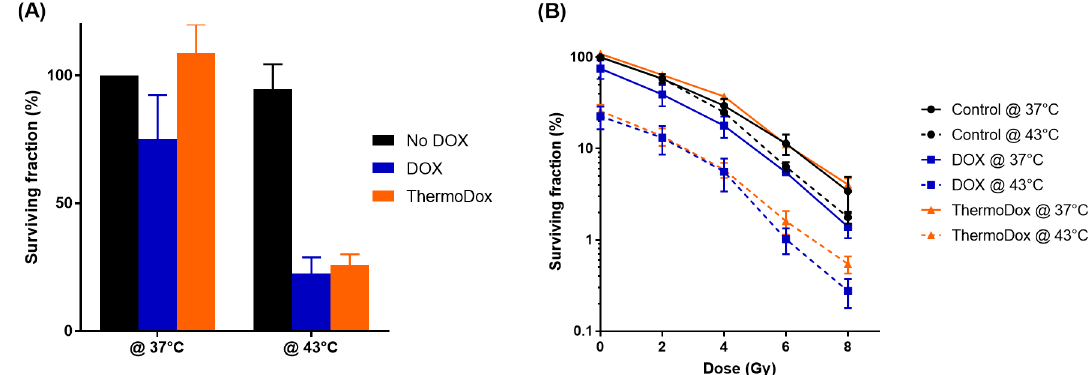
Fig 1. Cytotoxicity of free DOX and DOX from ThermoDox at different temperatures with and without RT. Surviving fraction of HT1080 cells exposed to DOX (0.02 μg/mL) or ThermoDox (0.02 μg/mL) for 1 hour at 37˚C or 43˚C without (A) or with (B) RT. ThermoDox at 37˚C, with or without RT, resulted in equal toxicity compared to treatment without a drug, however ThermoDox at 43˚C resulted in comparable toxicity compared to DOX treatment.